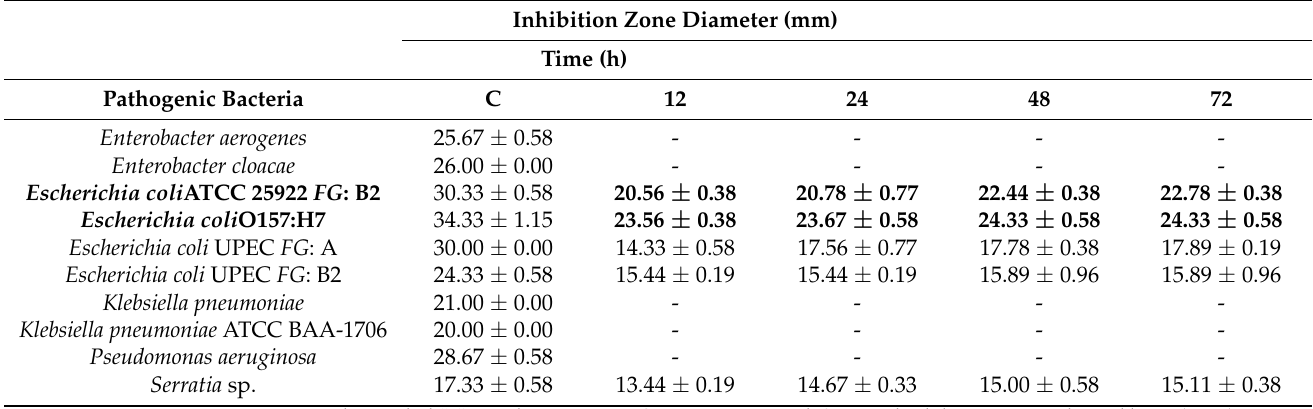
Table 5. Antibacterial activity per diameter (mm) of inhibition halos generated by Gloeocystidiellum lojanense against the bacterial strains under study.